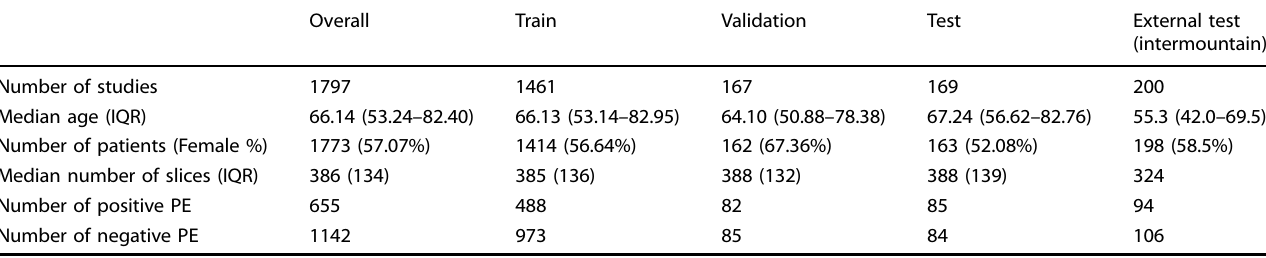
Table 3. Data characteristics of the internal (SMC) and external (Intermountain)